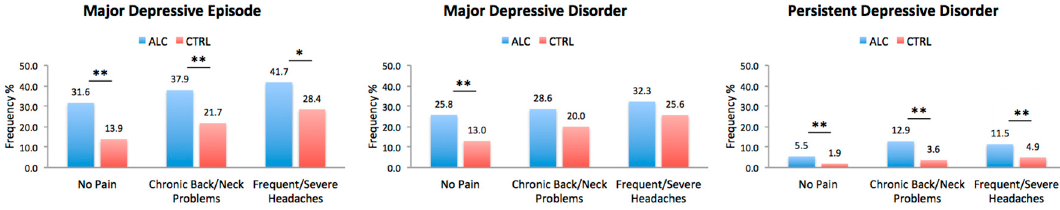
Figure 2. Depressive Diagnoses in ALC vs. CTRL in the Presence or Absence of Chronic Pain. The plots represent the lifetime incidence of depressive disorders in individuals with and without chronic pain (No Pain, Chronic Back/Neck Problems, or Frequent/Severe Headaches) with or without a history of alcohol abuse. CTRL refers to individuals with no history of alcohol abuse. Abbreviations: ALC, Alcohol Abuse Cohort; CTRL, Control Cohort. * p < 0.0166, ** p < 0.0033 adjusted thresholds with Bonferroni correction for three comparisons for the three depressive disorders.